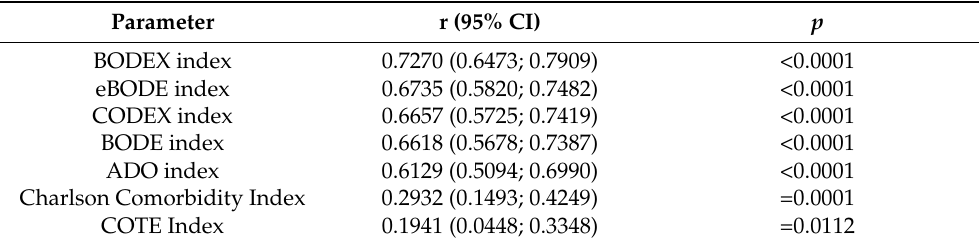
Table 2. Correlation analysis with COPD stage at the second control point.